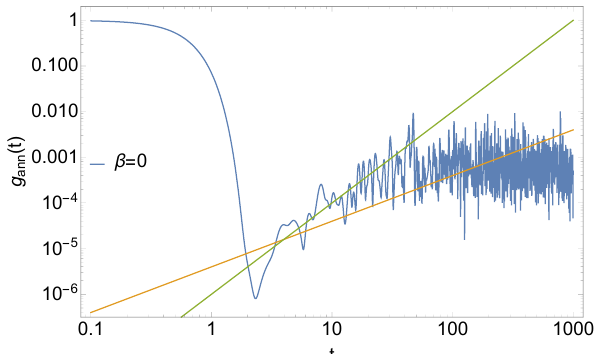
Figure 19. SYK2 model with number of sites N = 20 . The ramp is fit with linear lines of slope 1 (yellow) and 2 (green). Averaging is done over hundred randomly chosen J from a normal distribution with mean µ = 1 and variance σ = 0 . 005